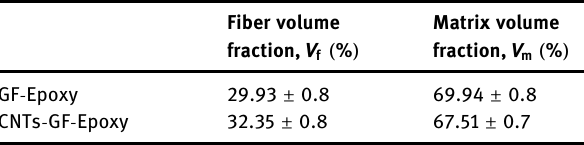
Table 2: The constituent of volume fraction of control and hybrid sample